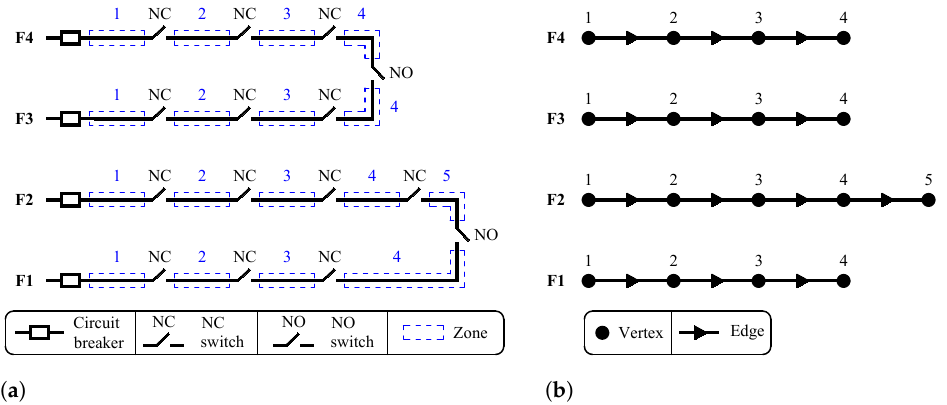
Figure 7. Representation of the distribution network at bus 5 of the RBTS. ( a ) Zone diagram. ( b ) Ori- ented